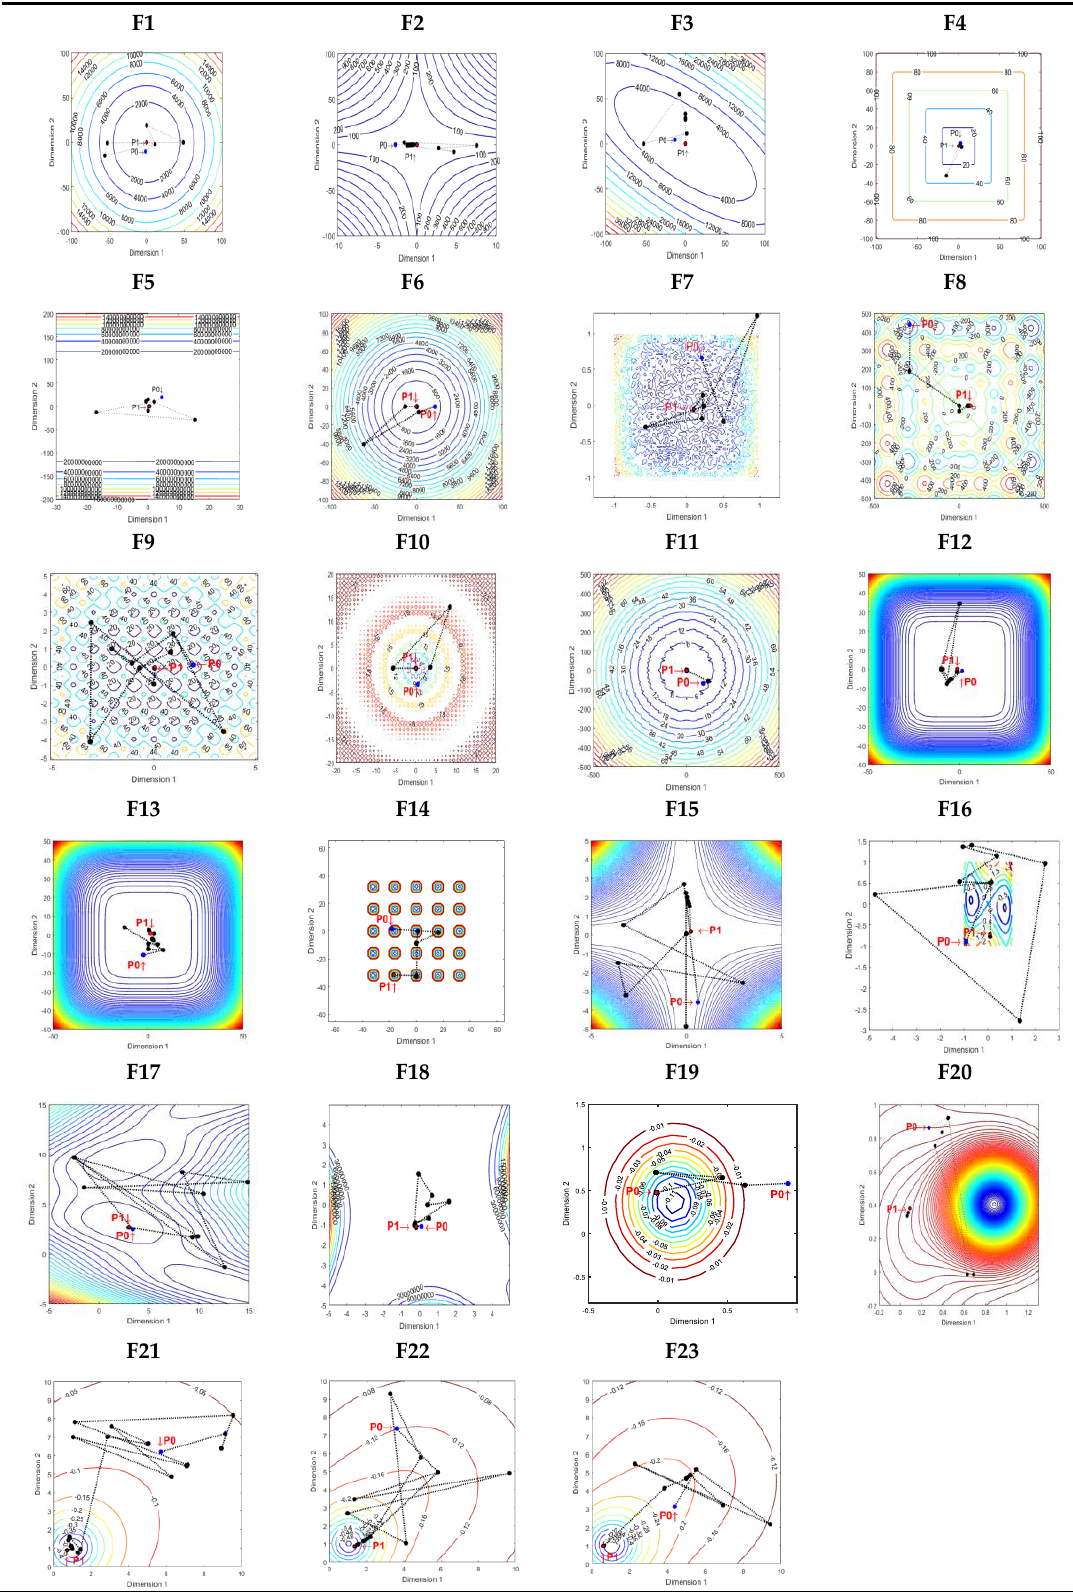
Table 19. Trajectory of the best solutions for the 23 benchmark functions.